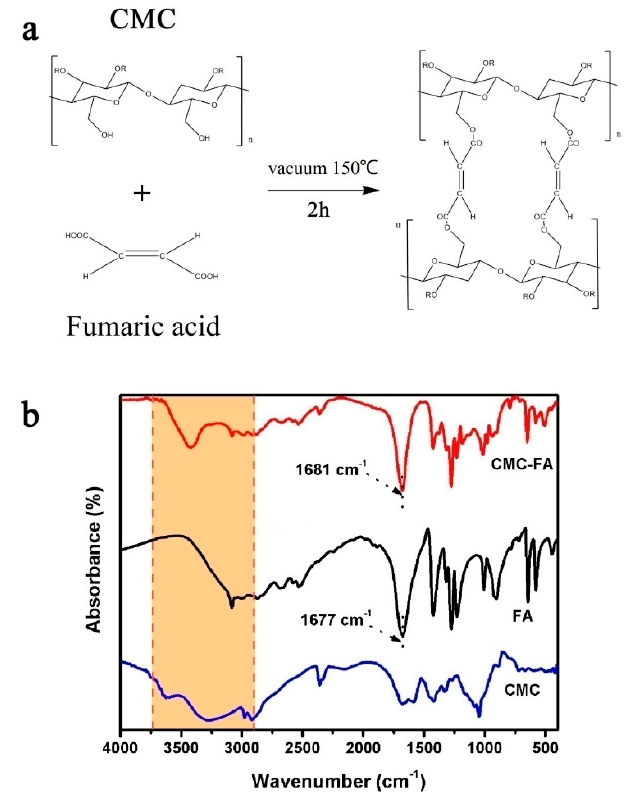
Figure 2. ( a ) The schematic of esterification reaction between CMC and FA; ( b ) FTIR spectra of FA, CMC and CMA-FA polymer network.